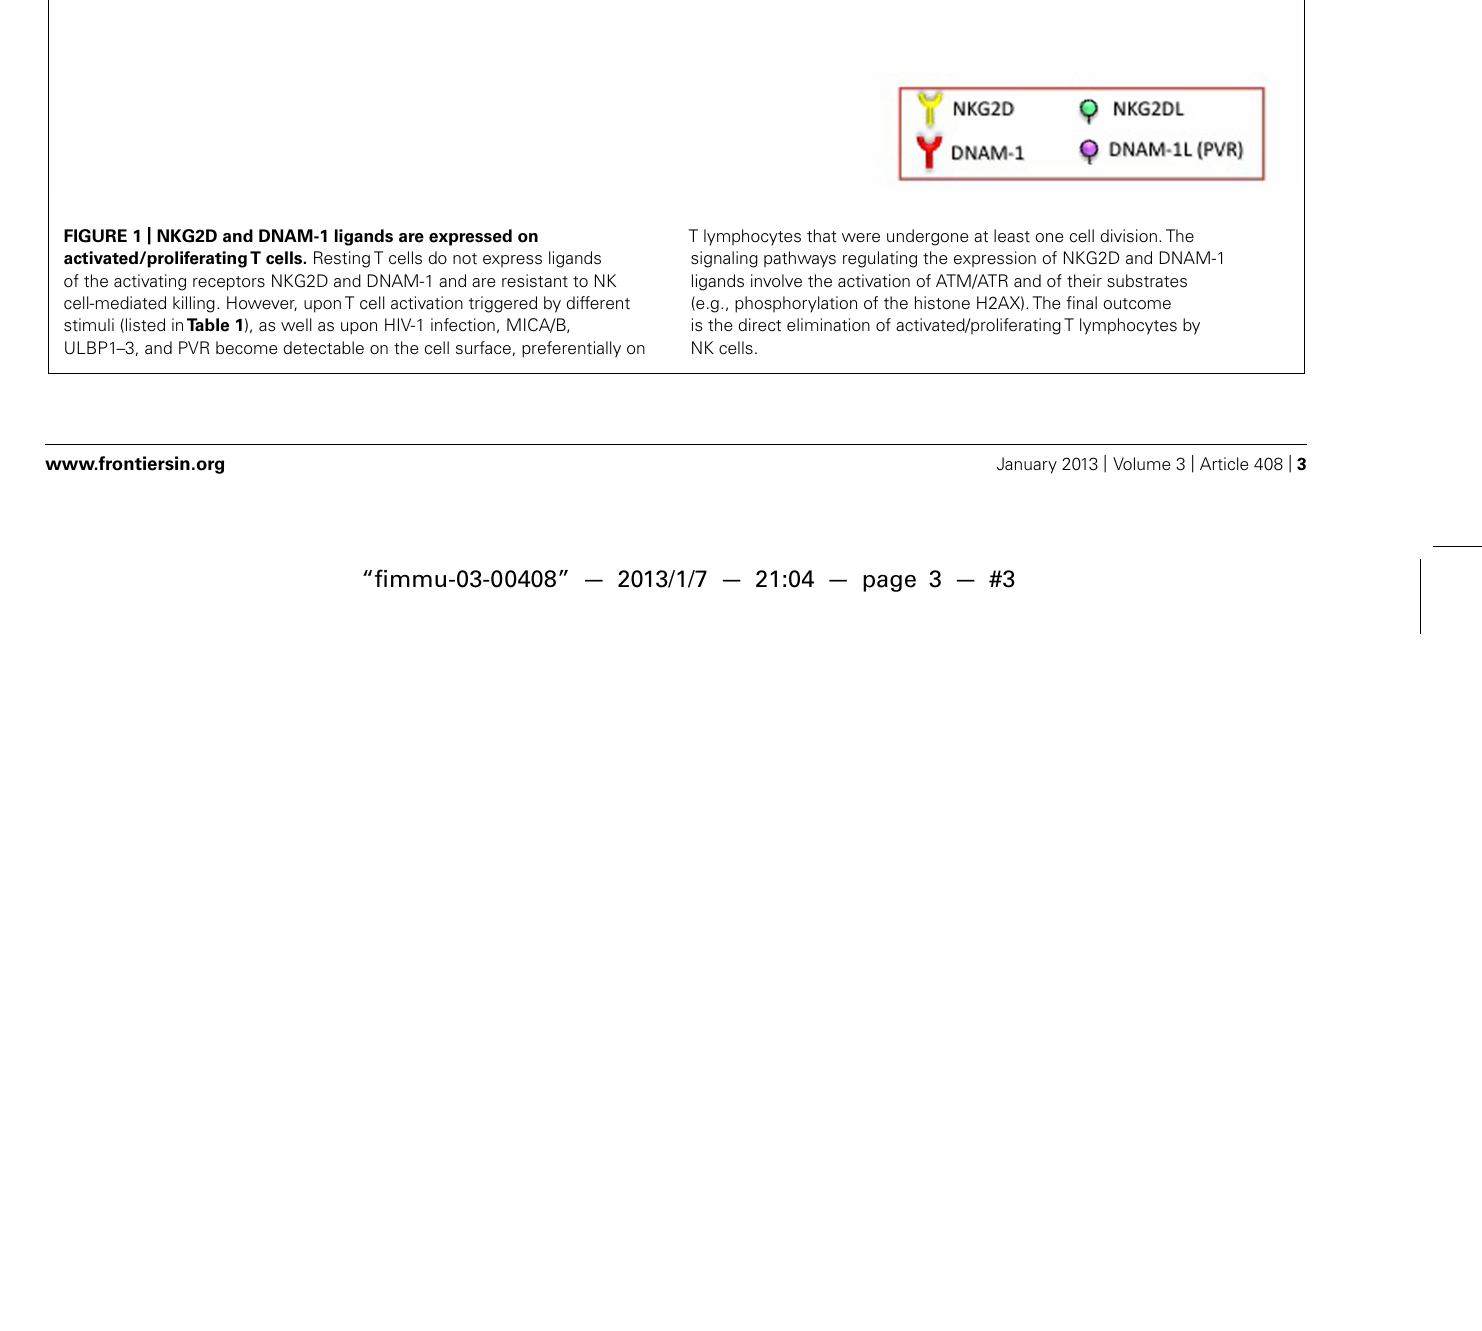
T lymphocytes that were undergone at least one cell division.The signaling pathways regulating the expression of NKG2D and DNAM-1 ligands involve the activation of ATM/ATR and of their substrates (e.g., phosphorylation of the histone H2AX).The final outcome is the direct elimination of activated/proliferatingT lymphocytes by NK